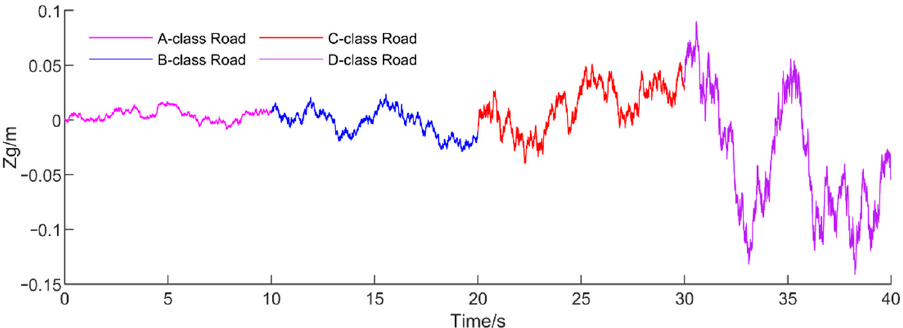
Figure 3. Time domain response curve of the composite road.